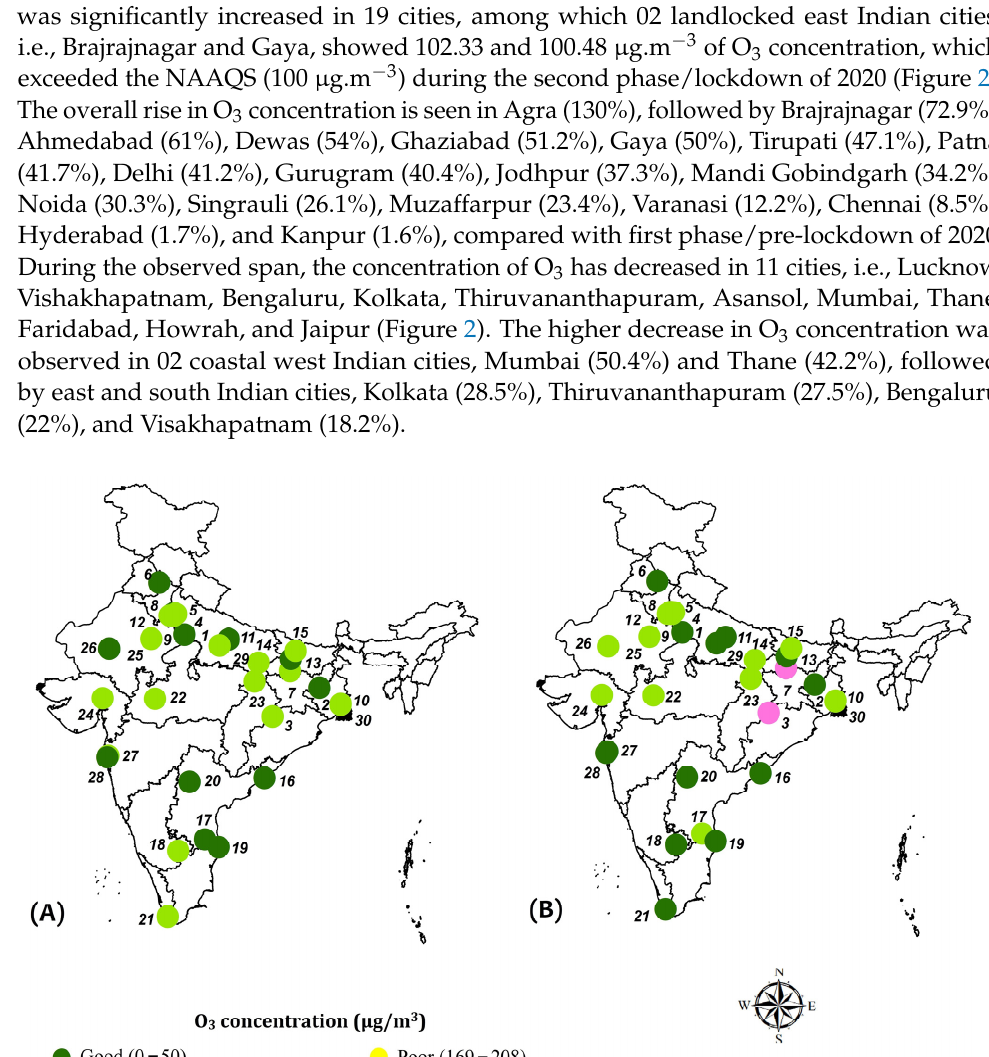
adopted from the breakpoints of O 3 (8 h.) in Indian National Air Quality